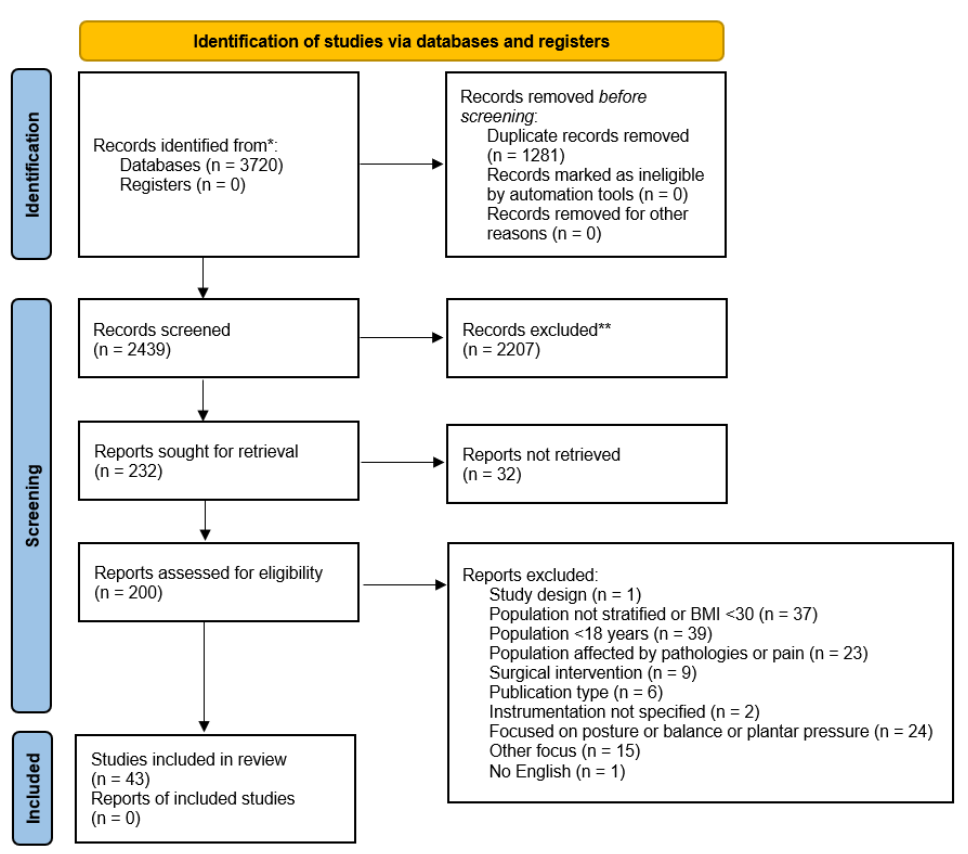
Figure 1. PRISMA diagram. * PubMed = 913; Scopus = 1659; Web of Science = 1148; ** manually